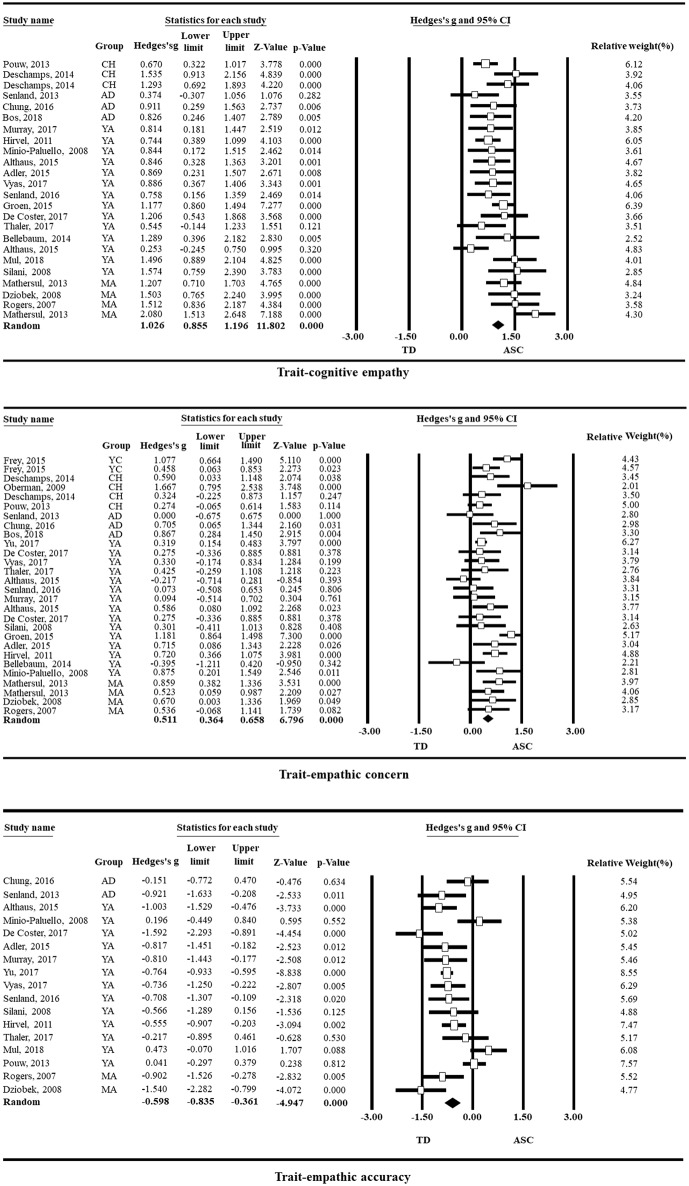
Forest plots of the impairment of the empathy components among ASC individuals (TO, Toddlers, aged 0–3 years; YC, Young children, aged 4–6 years; CH, Children, aged 7–12 years; AD, Adolescence, aged 13–18 years; YA, Young adults, aged 19–39 years; MA, Mature adults, aged of 40–59 years; SE, Seniors, aged ≥ 60 years).